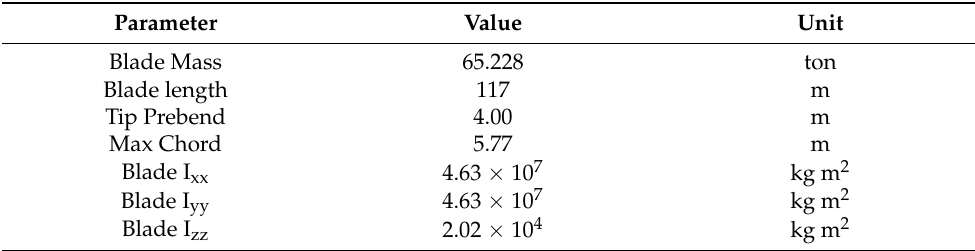
Table 4. Blade Key